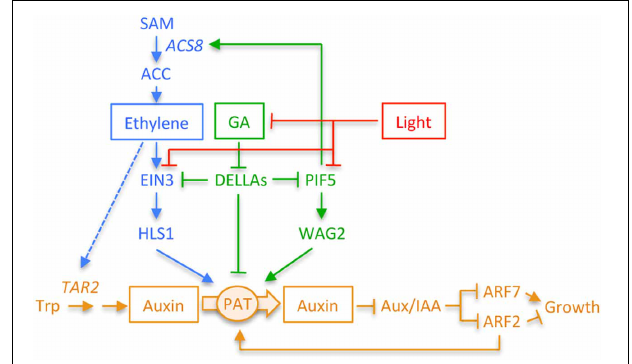
FIGURE 3 | Diagram depicting the interactions between GAs, ethylene, and light signaling pathways in Arabidopsis and how they modulate the auxin response in the apical hook. Not all interactions take place simultaneously. The differential auxin response is required during the whole process of hook development, and it is modulated by GAs and/or ethylene depending on the phase. GAs are relevant during the formation phase, whereas the role of ethylene during this phase seems to be minor. The mechanism by which GAs control the auxin response during the formation phase is unknown, although it will likely involve HLS1 regulation. Both GAs and ethylene are, however, important to prevent opening, and thus the interactions between both hormones will take place during maintenance. The signaling elements involved in the regulation of TAR2 by ethylene are unknown (discontinuous blue line). Light may provoke hook opening at any stage of hook development. Bars and arrowheads indicate negative and positive effects, respectively. PAT, polar auxin